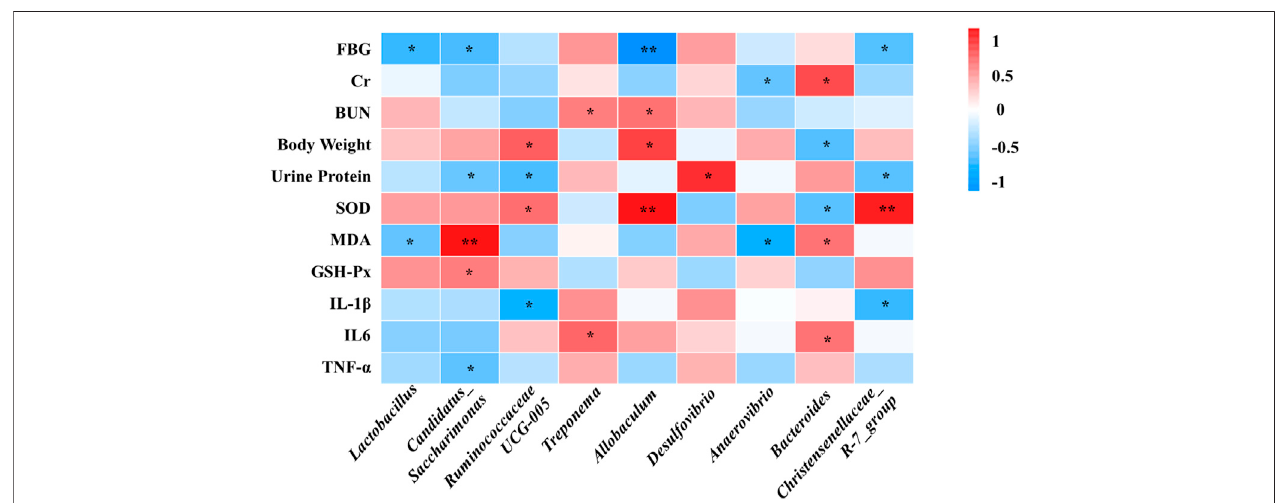
FIGURE 5 | Correlations between between physiological data, oxidative stress and in fl ammatory factors and gut microbiota were analyzed using spearman ’ s analysis(heatmap). X -axisrepresentsthegutmicrobiota withdifferentialabundance. Y -axis represents the physiological data, oxidative stressand in fl ammatoryfactors. The colors of grids represent the correlation analysis value of spearman ’ s correlation analysis. Grids in red indicate positive correlations (correlation analysis value more than0.1),whilegridsinblueindicatenegativecorrelations(correlationanalysisvaluelessthan − 0.1).Colorcodingscaleindicatesthecorrelationanalysisvaluefrom heatmap,thedeeperredorblueindicateshighercorrelationvalues.*: p < 0.05betweenphysiologicaldata,oxidativestressandin fl ammatoryfactorsandgutmicrobiota. **: p < 0.01 between physiological data, oxidative stress and in fl ammatory factors and gut microbiota.